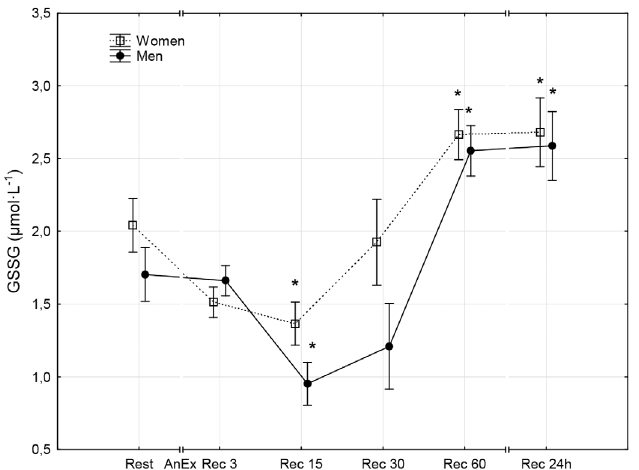
Fig 8. Oxidized glutathione concentration (GSSG) in the blood prior to (Rest) and 3 minutes (Rec 3), 15 minutes (Rec 15), 30 minutes (Rec 30) and 60 minutes (Rec 60) after anaerobic exercise (AnEx). Data are given as mean ± standard error; * p < 0.05 statistically significant differences between results obtained after anaerobic exercise (AnEx) and initial results